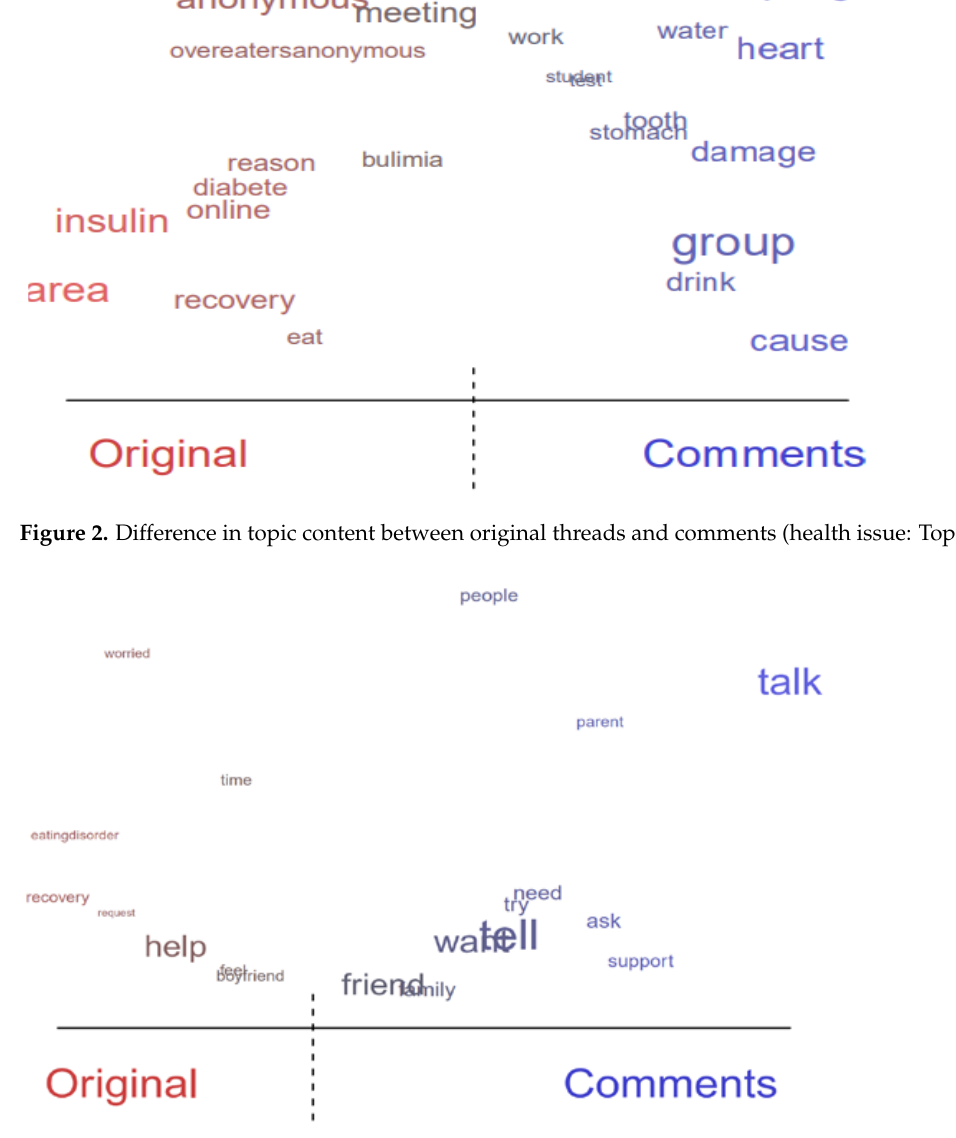
Figure 4. Difference in topic content between original threads and comments (exercise routine: Topic 14). 3.5. The Effects of Topical Structure on the Net Score To identify which topics were largely supported by members of the online ED com- munity, we performed regression analysis to gauge the effects of topical structures on net scores (Table 3). That is, whether certain topics had higher or lower votes from other ED members. In addition to the regression coefficient, topic weights were considered to clas- sify the topics into two categories: topic popularity and votes. Topic popularity was de- termined based on topic weights. If a topic had a topic weight greater than the median topic weight, this topic was classified as high popularity, while a topic with lower topic weight was classified as low popularity. Three topics had significantly positive regression coefficients: self-esteem for exist- ence (Topic 1, p < 0.001), feeling in control (Topic 3, p < 0.05), and self-esteem for health (Topic 5, p < 0.001), suggesting that many members of the ED community supported the underlying ideas of those topics. In general, all these topics are related to emotional sup- port. In contrast, five topics had a negative significant regression: research requests and resource seeking (Topic 2, p < 0.001), snacking behavior (Topic 6, p < 0.05), various issues related to EDs (Topic 9, p < 0.05), professional help (Topic 10, p < 0.001), and ED diagnosis (Topic 12, p < 0.001). These topics, all related to informational support, tended to have negative coefficients. Finally, four topics had insignificant coefficients: ED recovery (Topic 4, p > 0.05), communication (Topic 8, p > 0.05), binge eating (Topic 13, p > 0.05), and exercise